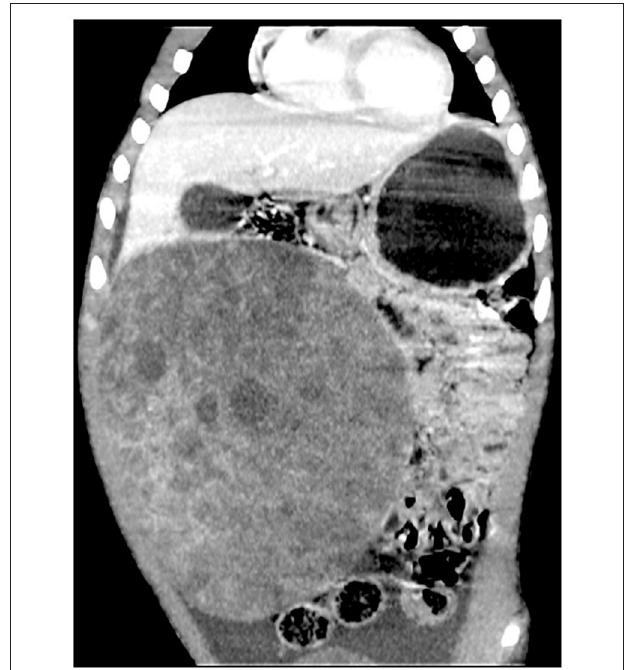
FIGURE 3 | Enhanced CT of three-dimensional reconstruction. The adjacent right branch of the proper hepatic artery, abdominal aorta, right common iliac artery, and mesenteric vein was displaced by compression, and the distal branches of the hepatic artery were penetrated within the tumor.